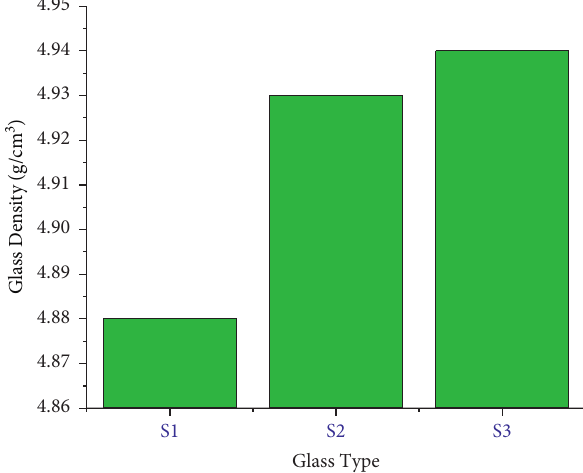
Figure 2: Variation of glass densities (g/cm 3 ).